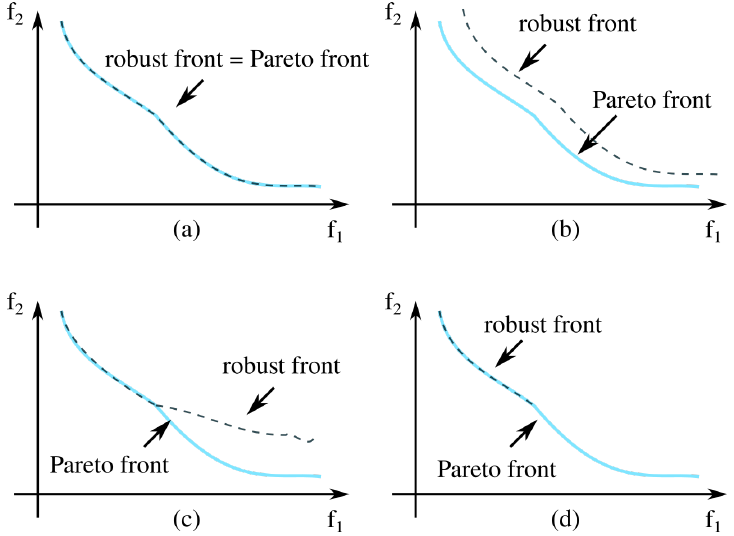
Figure 5. The four possible positions of the robust front compared to the Pareto-front of the multiobjective solution: ( a ) complete Pareto front is robust, ( b ) complete Pareto front is not robust, ( c ) a part of Pareto front is not robust and ( d ) a part of Pareto front is